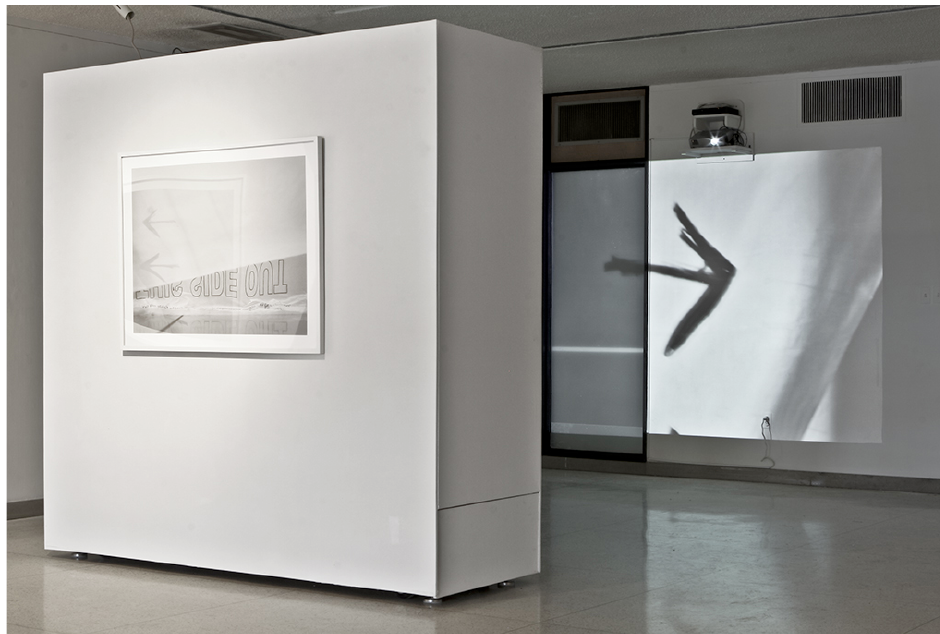
Installation view of Likewise, as technical experts, but not (at all) by way of culture, Penelec Gallery (Allegheny College),